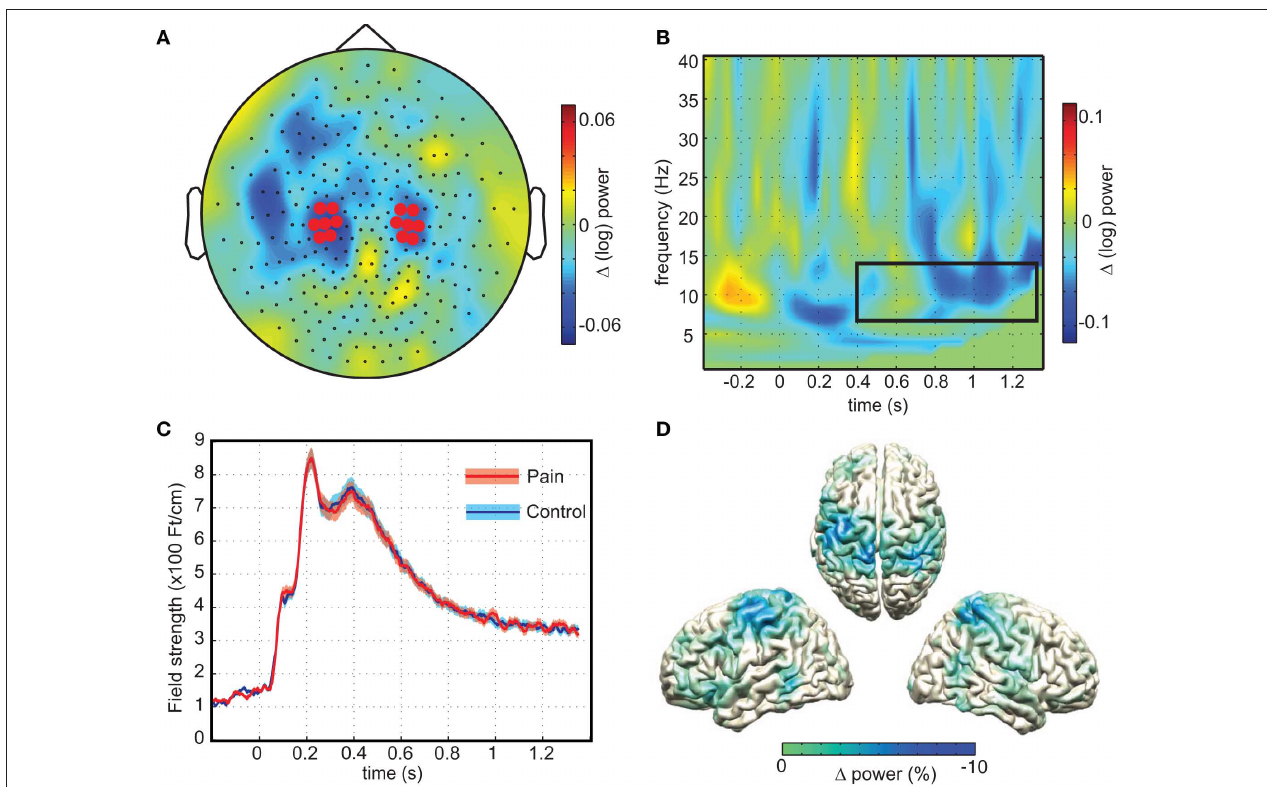
pain minus no-pain condition of the highlighted sensors in (A) . Box depicts time–frequency window of interest ( p = 0.019). (C) Evoked responses and SD for pain and no-pain averaged over highlighted sensors from (A) . (D) Source reconstructions of alpha difference obtained using beamformer, showing sources along the